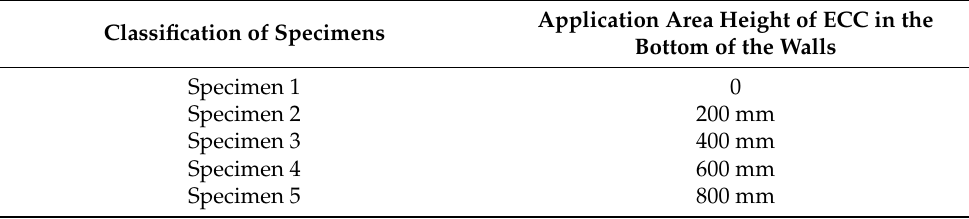
Table 1. The variation parameters of the use area of ECC in the bottom of the walls. Classification of Specimens